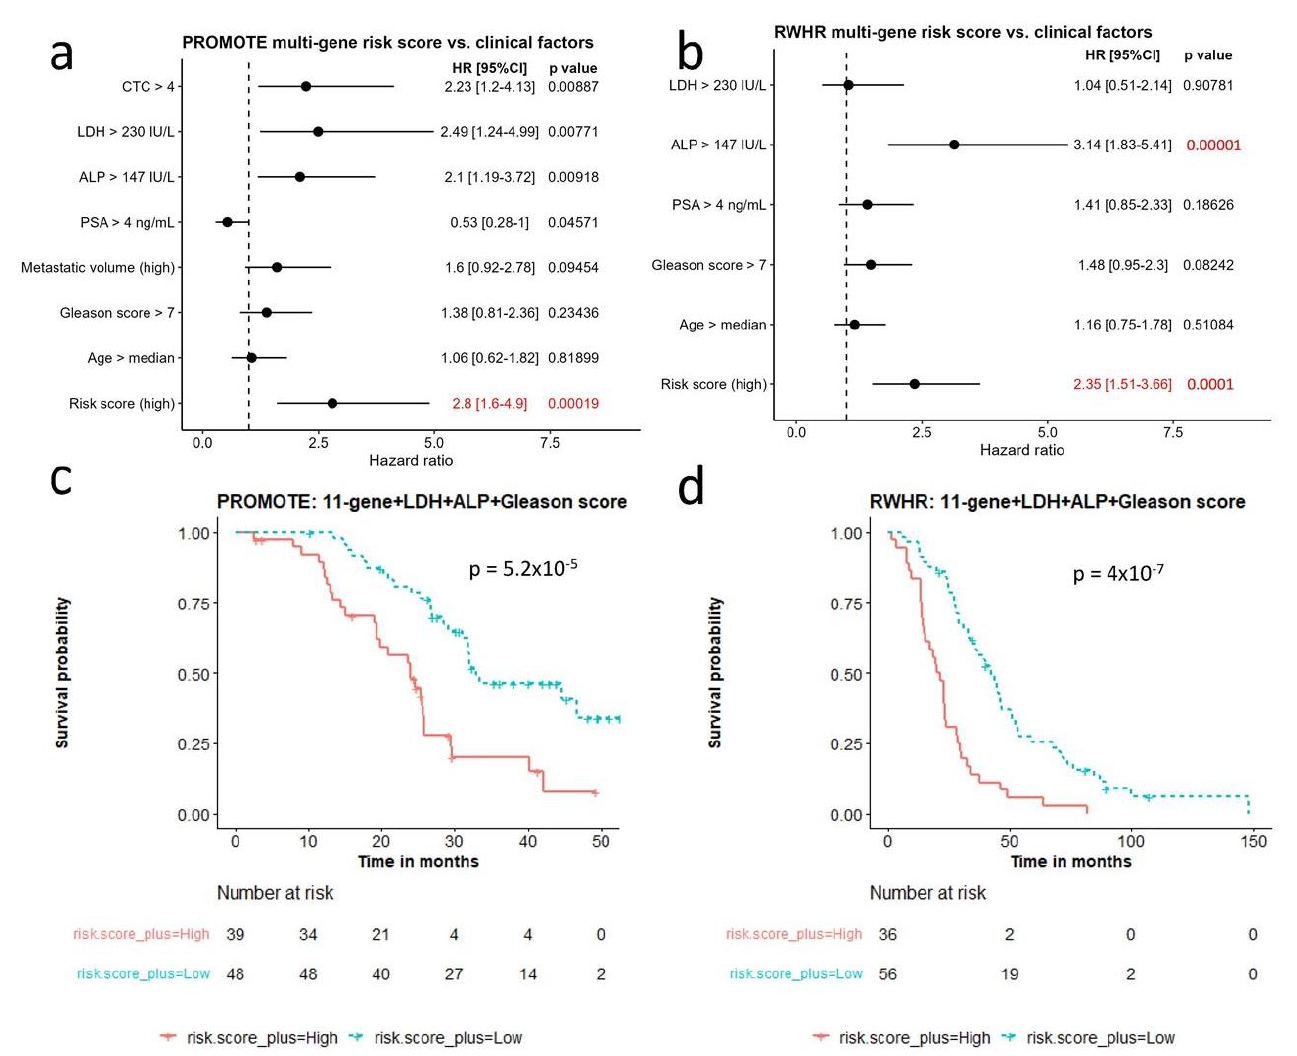
Figure 4. Comparison of multi-gene risk score with other clinical factors for survival. ( a , b ) Cox regression analysis comparing multi-gene risk score with seven survival-relevant clinical factors in the PROMOTE ( a ) and RWHR ( b ) cohort. Risk score (high) indicates 11-gene risk score above median value in the corresponding cohort. ( c , d ) Kaplan–Meier survival curves showing robust survival prognosis by the combination of 11-gene risk score, LDH, ALP, and Gleason score in the PROMOTE ( c ) and RWHR ( d ) cohort. CTC: circulating tumor cell; LDH: Lactate Dehydrogenase; ALP: Alkaline phosphatase; PSA: Prostate-specific antigen.